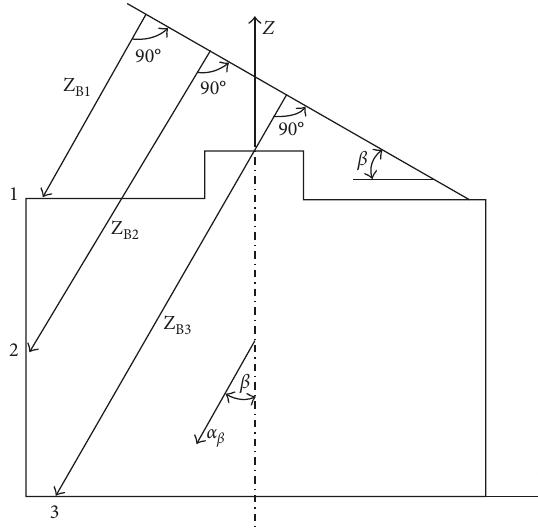
Figure 7: Determination of liquid height, Z